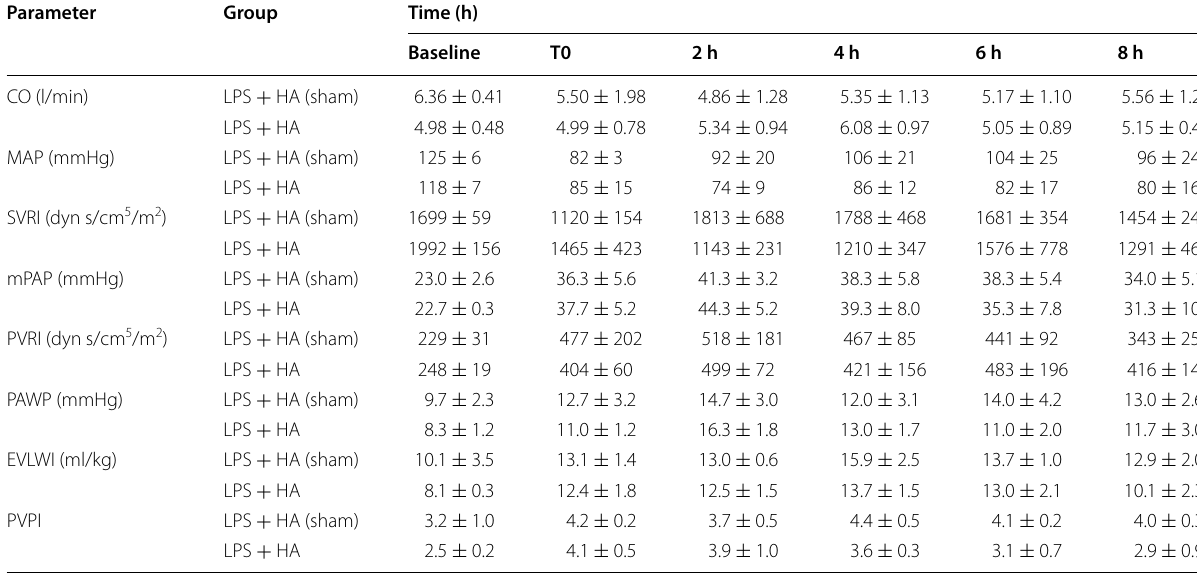
Hemodynamic parameters are shown in the LPS arterial pressure; SVRI, systemic vascular resistance index; MPAP, mean pulmonary arterial pressure; PVRI, pulmonary vascular resistance index; PAWP, pulmonary artery wedge pressure; EVLWI, extravascular lung water index; PVPI, pulmonary vascular permeability